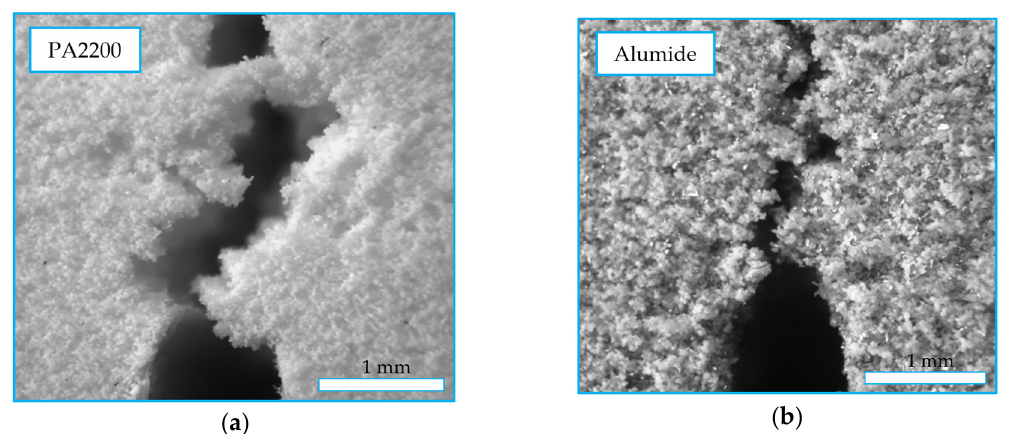
Figure 8. Crack propagation in polyamide ( a ) and Alumide ( b ) samples